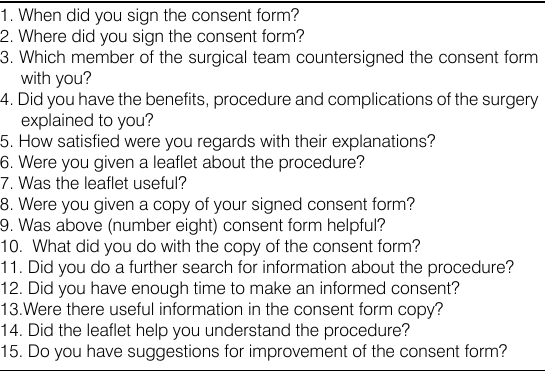
Table 1. Patient